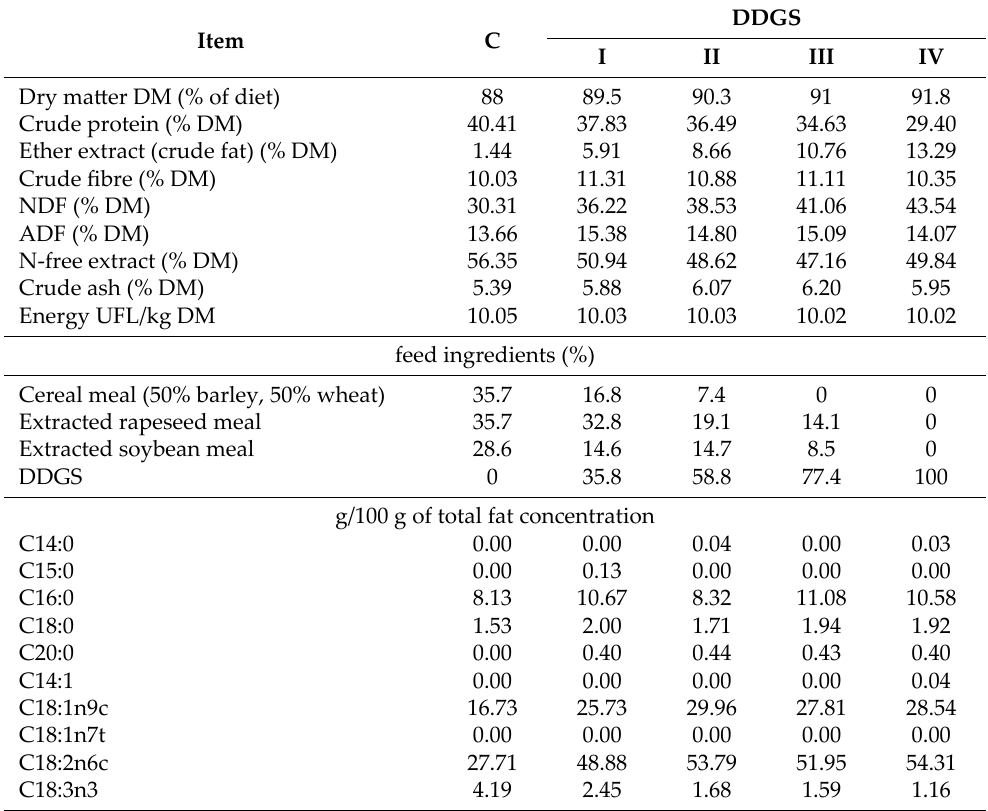
Table 2. Composition, chemical analysis, and nutritional value of substrates used in the in vitro